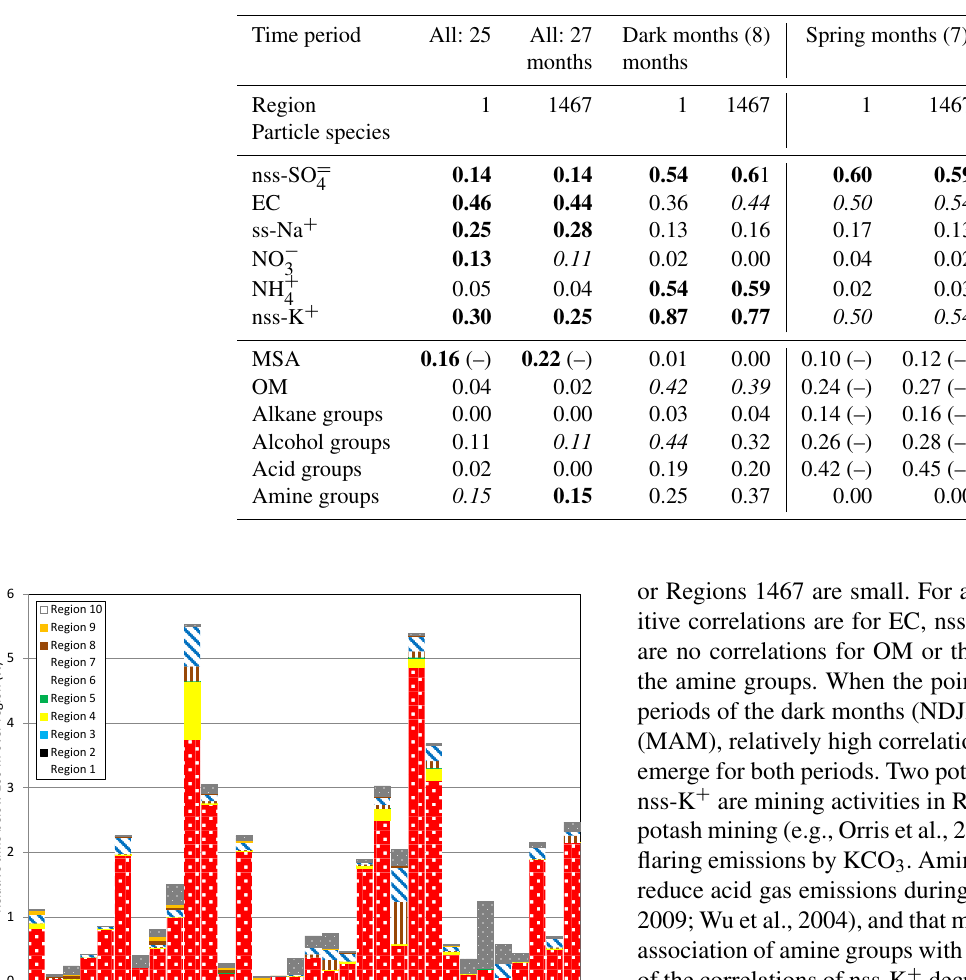
Table 2. Coefficients of determination ( r 2 ) for particle mass concentration linear regressions with times spent over indicated regions using monthly averages. Uncertainties in time over region are <75%. Dark months are NDJF and spring months are MAM. Values in italic font indicate p of slope is <0.10. Values in bold font indicate p of slope is <0.05. A minus sign in parentheses indicates a negative slope.